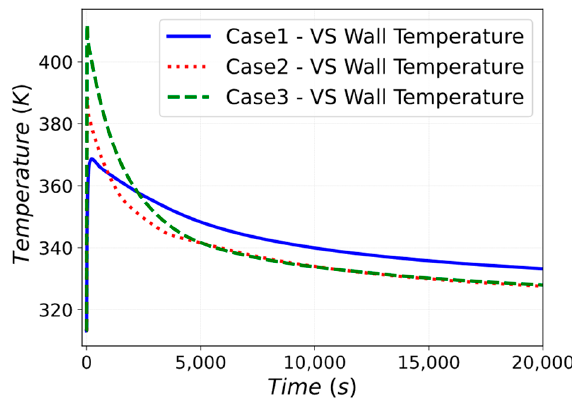
Figure 13. Temperature trend of the UPC wall.